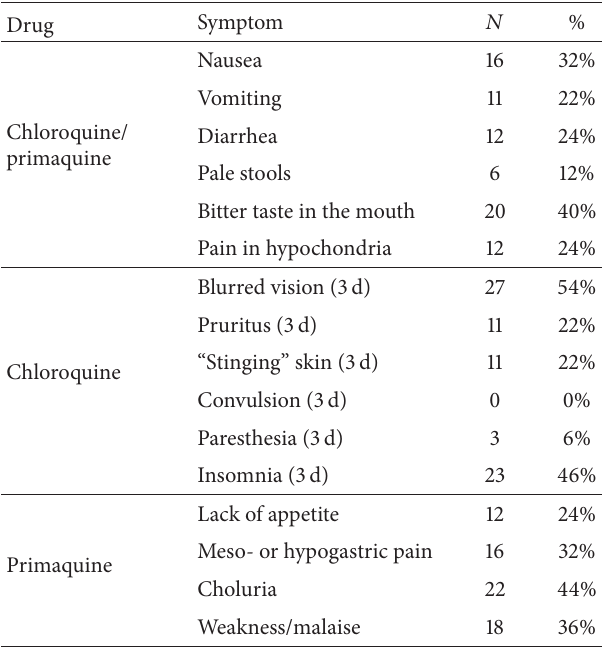
Table 3: Side effects of chloroquine and primaquine in treated patients with vivax